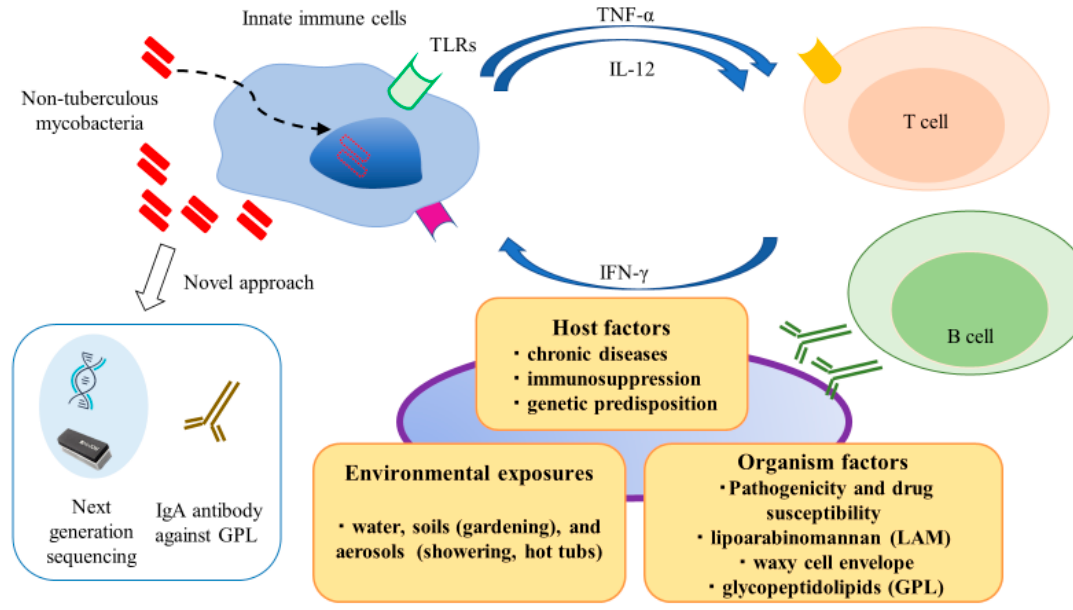
Figure 1. Schematic representation of complex interactions between hosts and pathogens in non- tuberculous mycobacteria (NTM) infection. Environmental exposures, host factors, and organismal factors contribute to development and progression of NTM infection. Comprehensive understanding of these processes is necessary for early and proper management of NTM